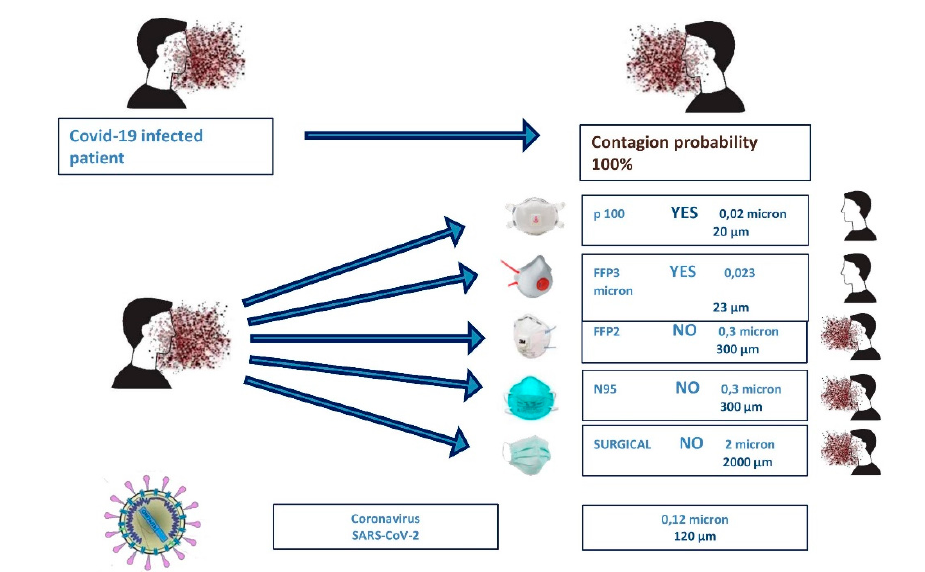
Figure 6. Di ff erent kind of masks and their e ff ectiveness regarding the protection for infection with Figure 6. Different kind of masks and their effectiveness regarding the protection for infection with COVID-19 (figure drawn by Giovanna COVID-19 (figure drawn by Giovanna Dipalma) .